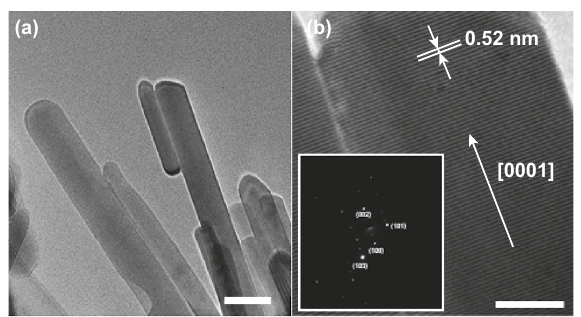
Fig. 3 a – b TEM images of the ZnO NWs on a ZP film. The insert in b is electron diffraction (SEAD) pattern. Scale bar: a 50 nm, b 10 nm